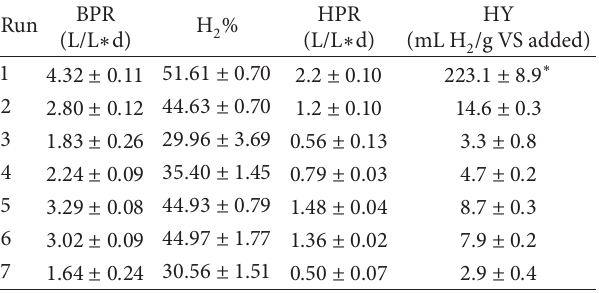
Table 2: Biogas production performance of the ASBR.